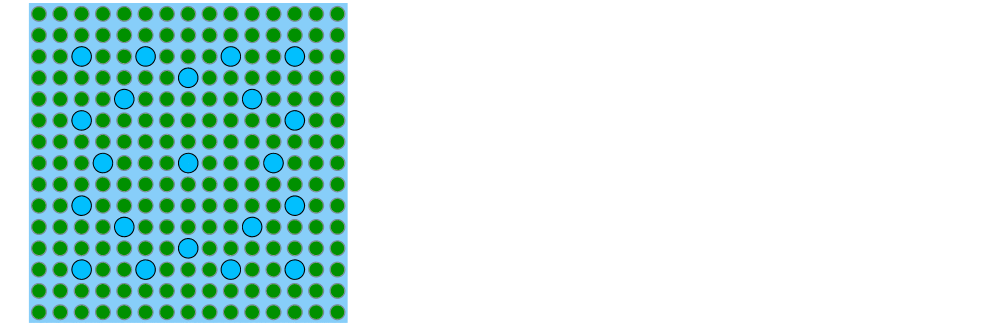
Figure 1. Radial cut of a UOX fuel assembly from the H.B. Robinson-2 reactor. Fuel rods are shown in green.